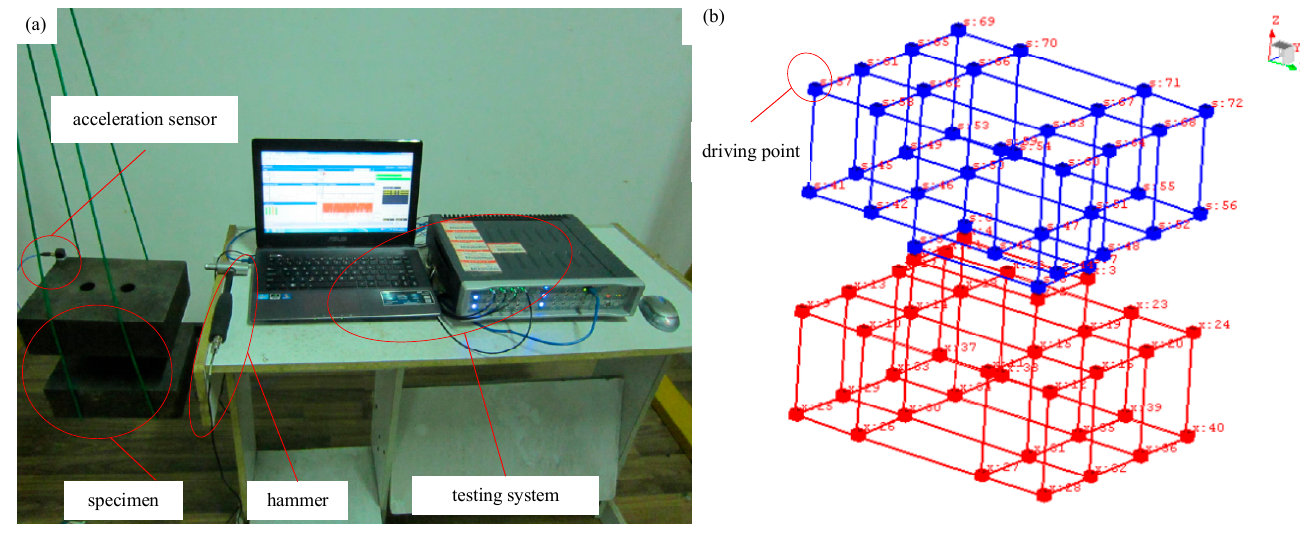
Figure 13. Experimental system: ( a ) testing system; ( b ) layout of measurement points and driving point.